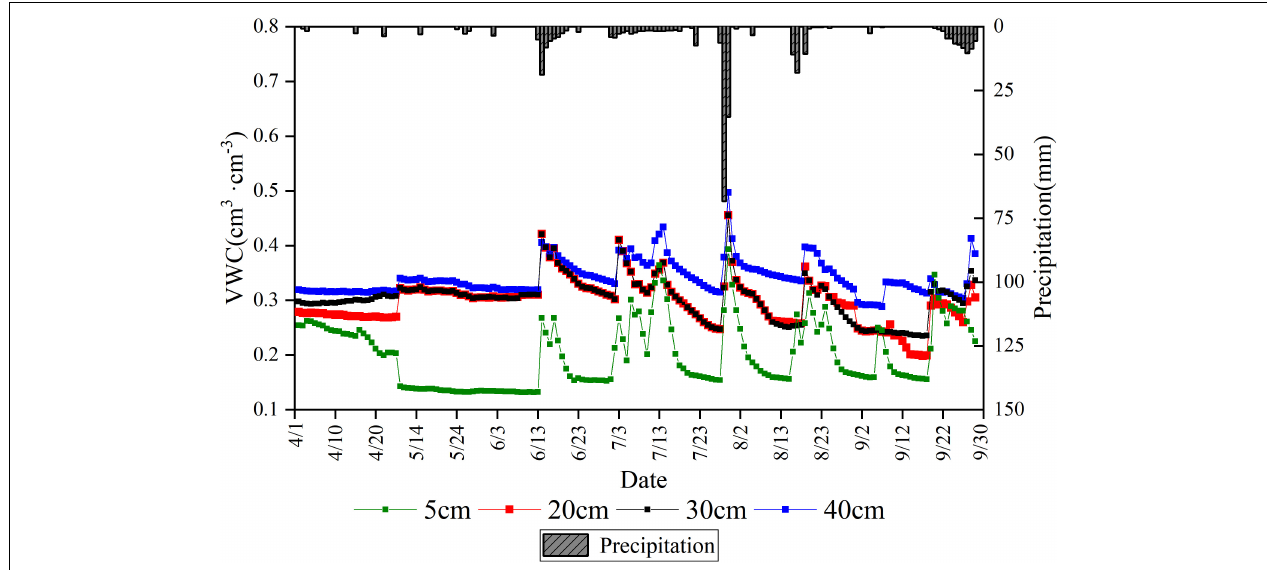
FIGURE 2 | Variation of precipitation and daily average soil volumetric water content at the